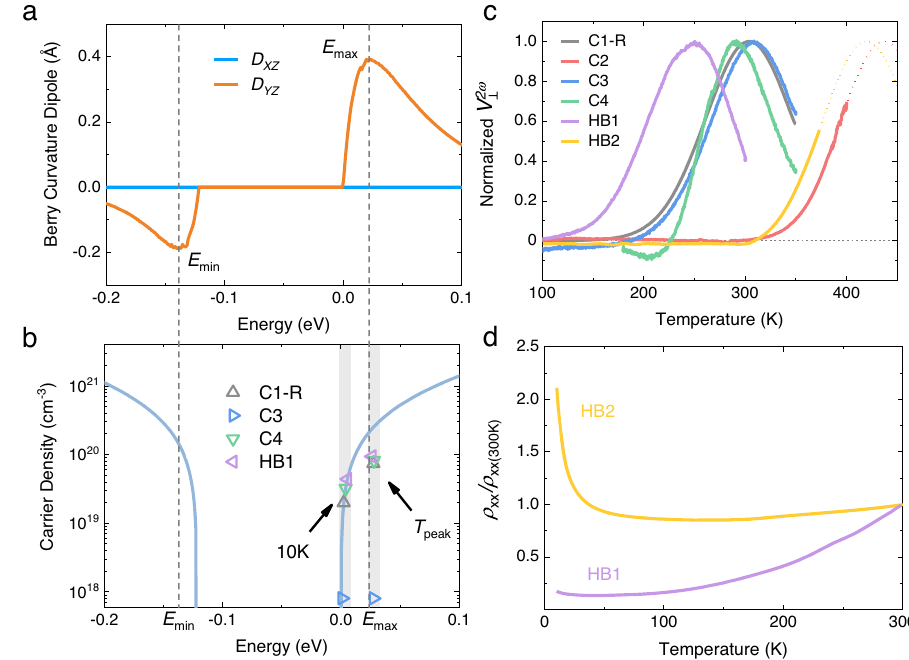
Fig. 4 | Comparison of the temperature dependence of NLHE with the energy dependence of BCD for BaMnSb 2 . a Calculated energy dependence of BCD. b Calculated energy dependence of carrier density and experimental carrier den- sitiesmeasuredat10Kandpeaktemperaturesofthesecond-harmonicHallvoltage V 2 ω ? for C1-R, C3, C4 and HB1. c Normalized